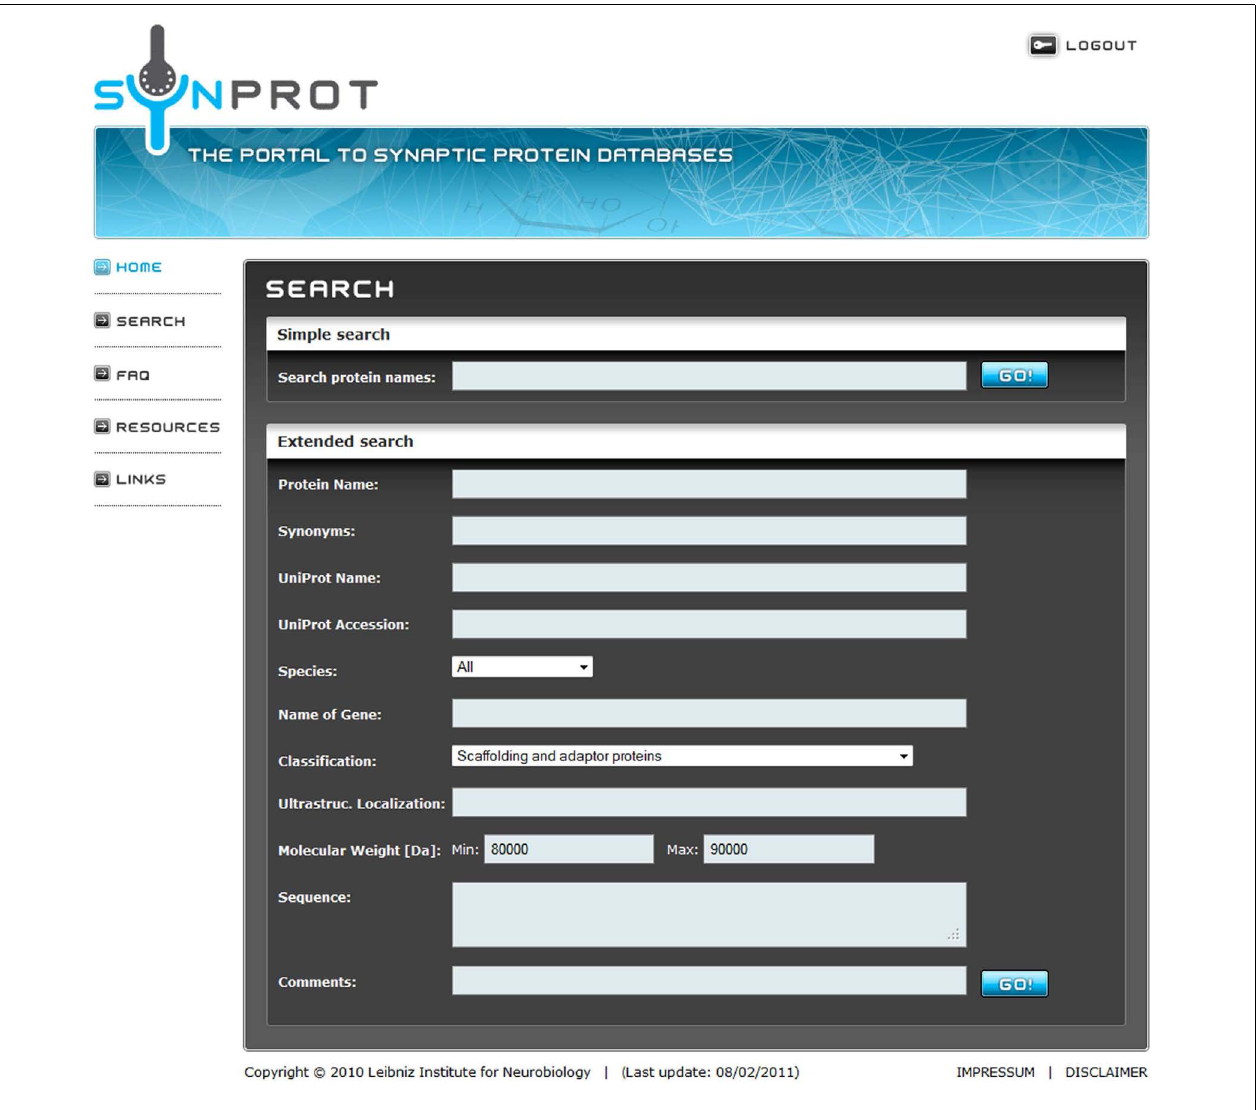
following criteria: (1) classified as “Scaffolding and adaptor proteins” and (2) a molecular weight between 80,000 and 90,000Da.The keywords are connected with a logical “AND” to accommodate detailed